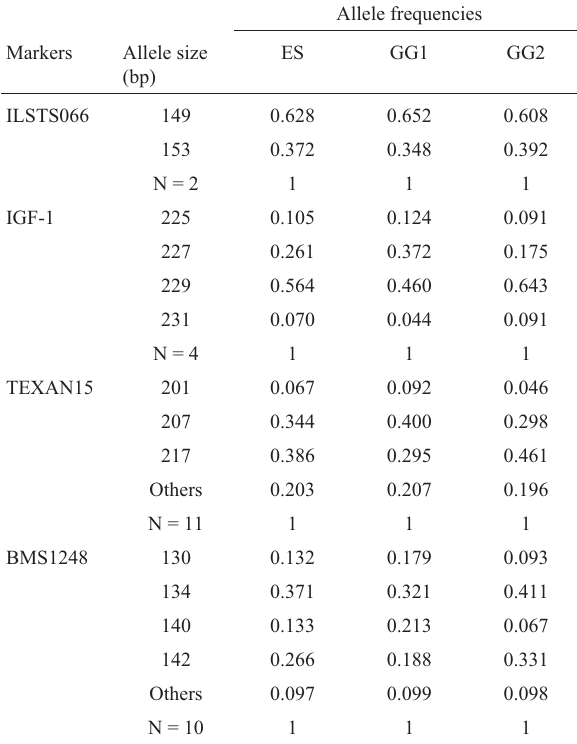
Table 1 - Allele frequencies for ILSTS066, IGF-1, TEXAN15 and BMS1248 in the entire sample and within genetic groups. Allele